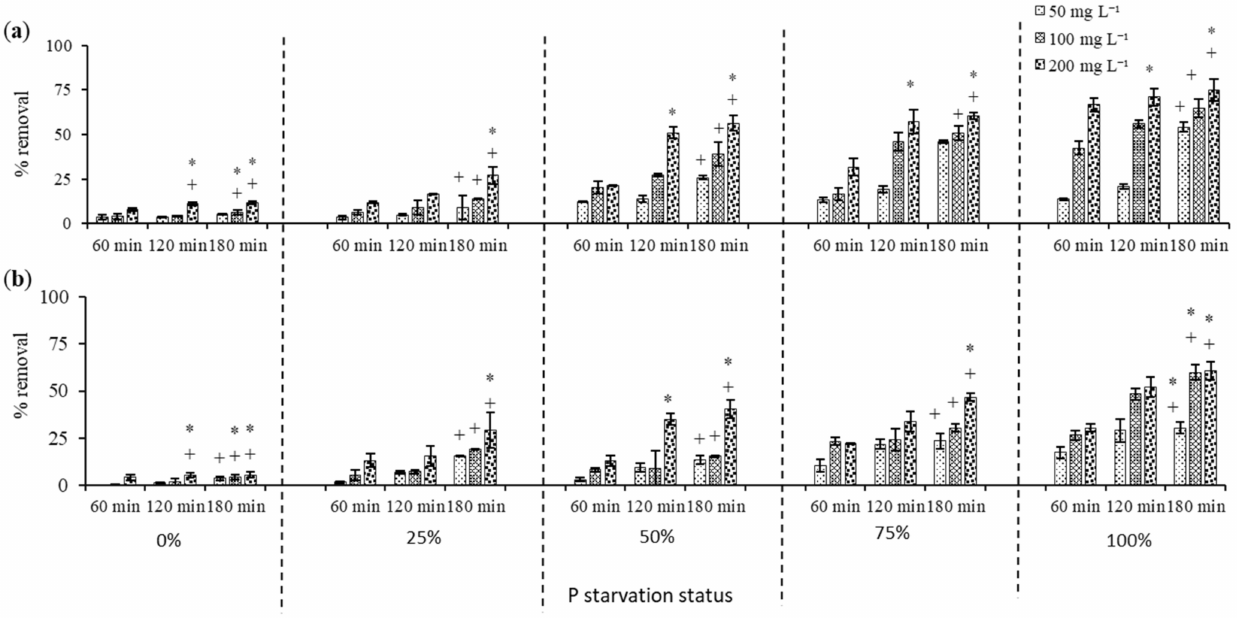
Figure 4. Percent removal of 2-chlorophenol by C. vulgaris dried biomass starved with 0, 25, 50, 75, and 100% phosphorus and further acid treated at ( a ) 70 mg L − 1 and ( b ) 150 mg L − 1 2-chlorophenol exposure. In all cases, p < 0.05, and n = 3 ± SE. + on bars, within each phos- phorus starvation status (0, 25, 50, 75, or 100%), represents the highest significant 2-chlorophenol removal at the specific time of exposure (60, 120, or 180 min) with the same concentration of biomass (50, 100, or 200 mg L − 1 ), while * on the bar represents the highest significant 2-chlorophenol removal in all